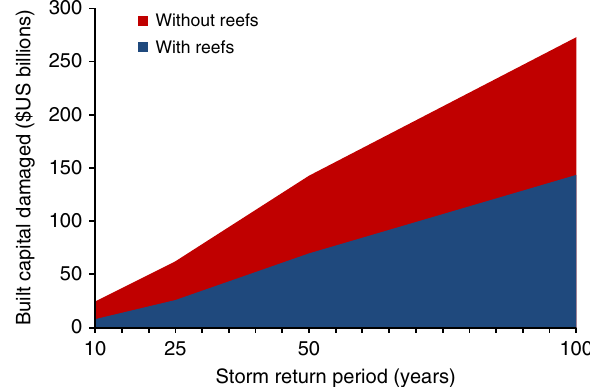
Fig. 3 The expected economic bene fi ts of coral reefs for fl ood protection in avoided damages. The values are the expected damages to global built capital from fl ooding with and without reefs by storm return period. The difference between the curves represents the avoided damages or bene fi ts provided by reefs at present